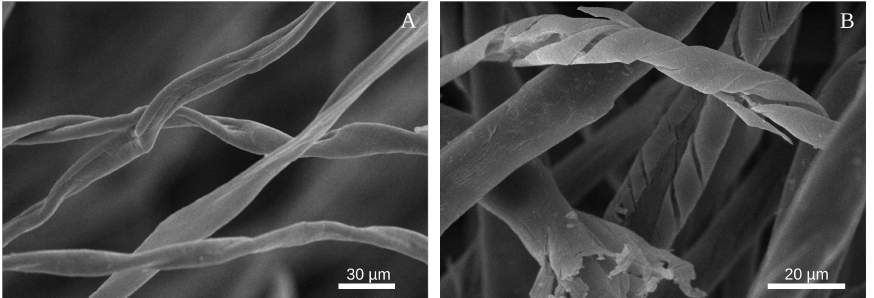
Figure A1. SEM images of the initial ( A ) and nitrated for 30 min ( B ) cotton cellulose. Cracking of the fibers reveals the helical structure invisible in the initial cellulose and in the MCC particles (Figure 2). For the details on the nitration process, please refer to [45].